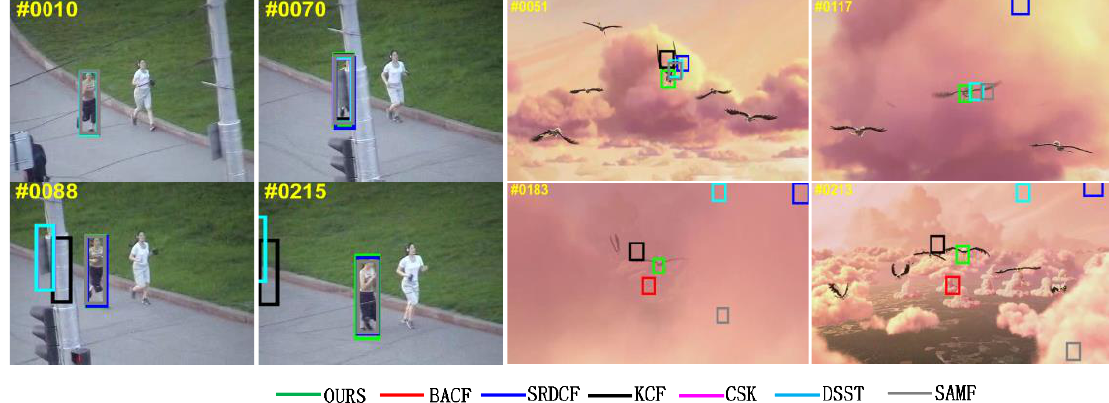
Figure 6. The tracking results of seven trackers on Jogging1 ( left ) and Bird1 ( right ).